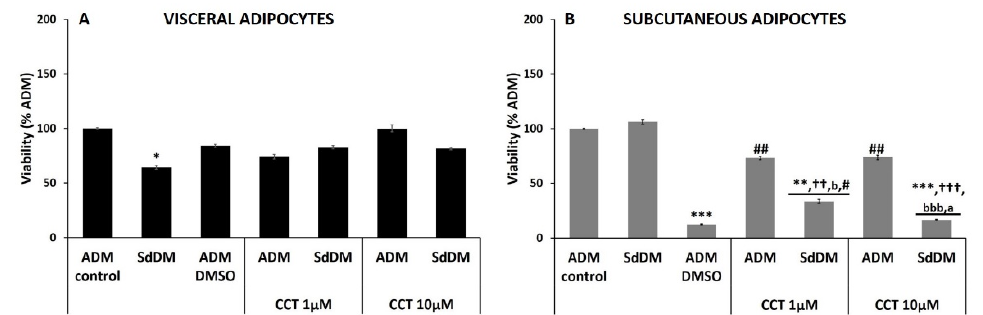
Figure 2. Effect of the SdDM secretome and CCT on the viability of adipocytes. The maximum cell viability detected for control differentiation (ADM-control) was set at 100%. Relative values of adipocyte viability in different conditions are shown: SdDM-differentiated cells, ADM–DMSO, and CCT applied to ADM- and SdDM-differentiated cells. Values were obtained at 17 days post-induction. Panel ( A ): percentage of cellular viability of visceral adipocytes. Panel ( B ): percentage of cellular viability of subcutaneous adipocytes. Bars indicate mean ± SEM of absorbance ( λ 595 nm) from at least three replicates of each condition. Significant differences are represented as: *, ** *** compared to ADM-control p < 0.05, p < 0.01, and p < 0.001, respectively. ††,††† compared to SdDM-control p < 0.01, and p < 0.001, respectively. #, ## compared to ADM–DMSO, p < 0.05 and p < 0.01, respectively. “a comparisons between CCT doses, p < 0.05. “b, bbb” comparison between SdDM–CCT and ADM–CCT (same dose), p < 0.05 and p < 0.001, respectively.